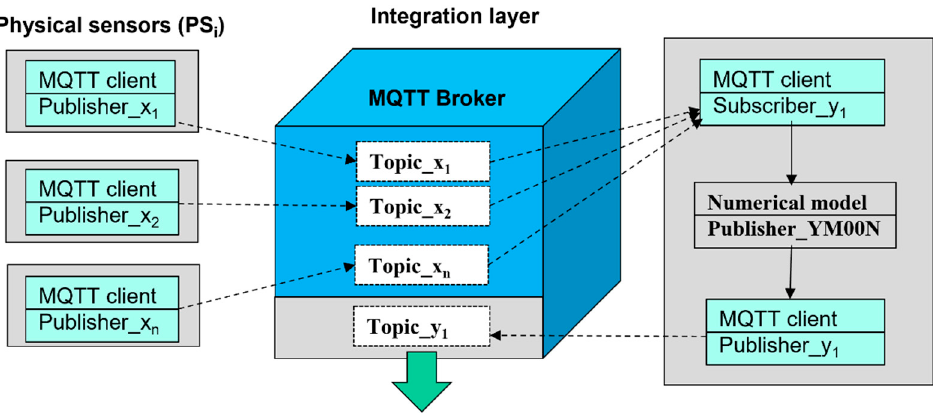
Figure 8. The concept of experimental workplace for simulation of virtual redundant sensors. RabbitMQ (software management tool Rabbit MQ) management console is shown in Figure 9, with configured connections of the physical sensors (blue box, IP address: 192.168.111.2 ...n) in publisher roles and the virtual redundant sensor in both publisher and consumer roles ( 192.168.111.1 ).